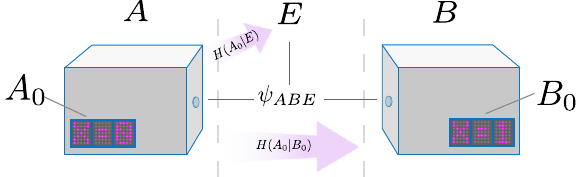
Fig. 2 Basic situation. By measuring her share of the joint state ψ ABE with measurement A 0 , Alice is (virtually) sending a raw key to Bob who (virtually) receives it by measuring B 0 . Bob ’ s uncertainty about Alice ’ s bit values is quanti fi ed by the classical entropy H ( A 0 ∣ B 0 ). We assume that Eve has access to all classical communication and her share of the joint quantum state, which gives her some partial information on A 0 as well. This is quanti fi ed by the classical-quantum entropy H ( A 0 ∣ E